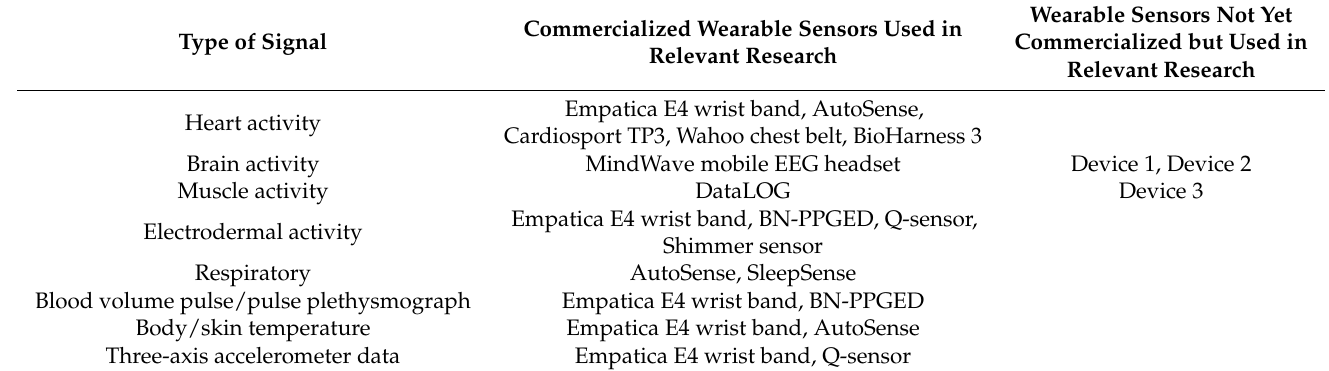
Table 2. Wearable sensors used in stress